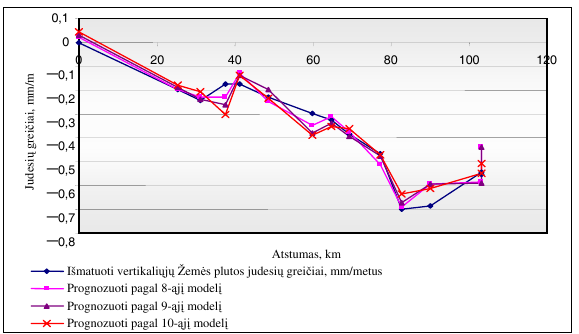
Fig 2. The graphs of measured and forecasted vertical earth